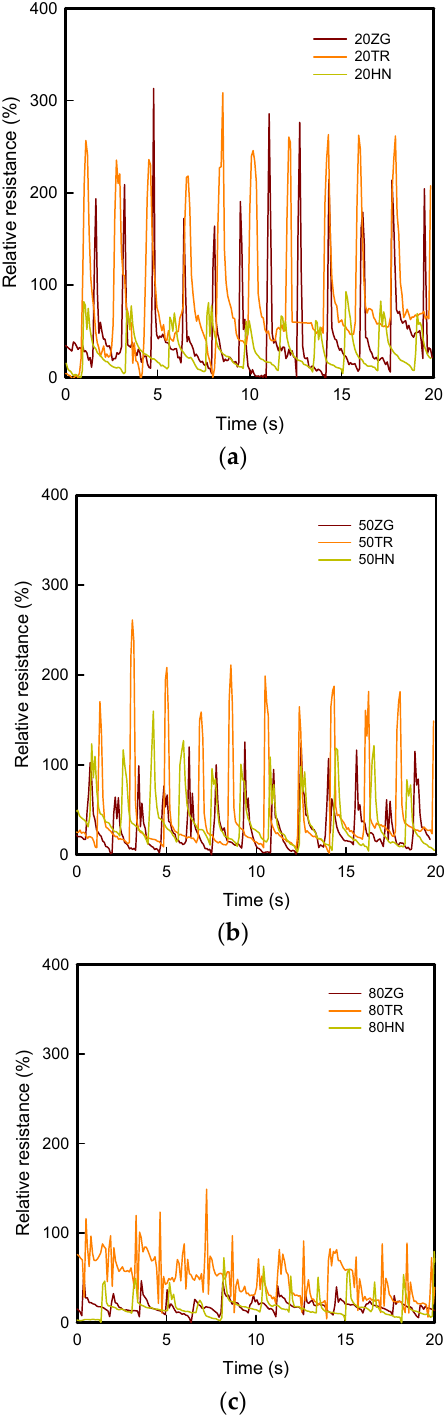
Figure 8. The relative resistance changes of coated 3DP index fi ngertips with 8 wt% GR/WPU com- posite solution under various in fi ll pa tt erns and densities: ( a ) 20% in fi ll density; ( b ) 50% in fi ll den- sity; ( c ) 80% in fi ll density.